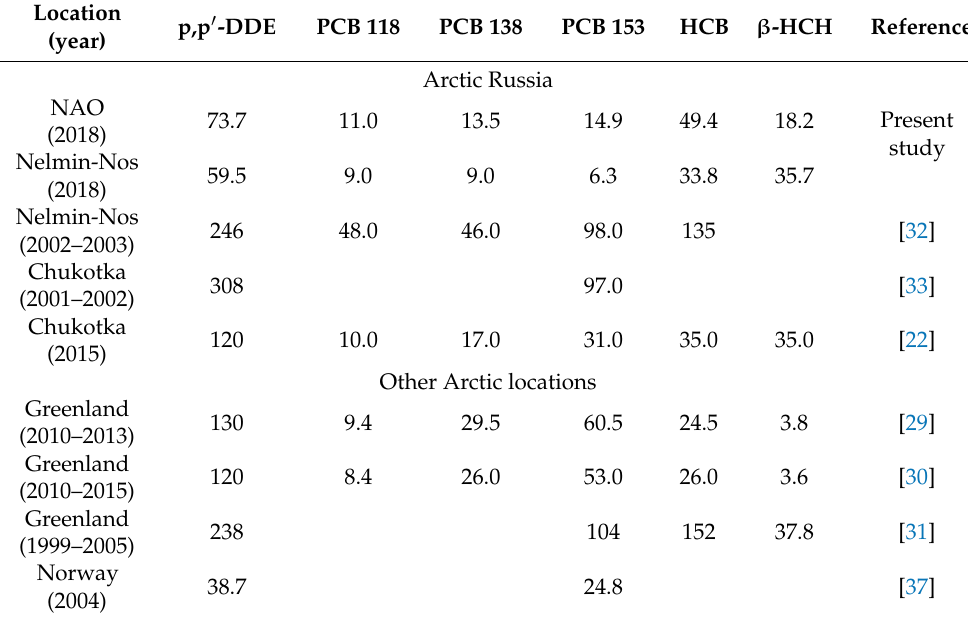
Table 4. Geometric means for selected POPs in women’s serum, ng/g